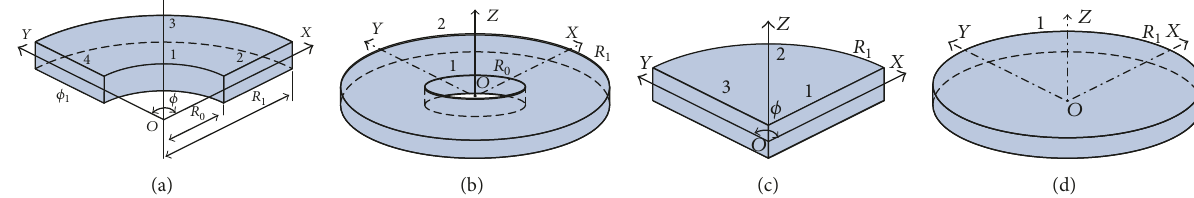
Figure 3: Isotropic annular sector plates of various types: (a) annular sector plate; (b) annular plate; (c) circular sector plate; (d) circular plate.